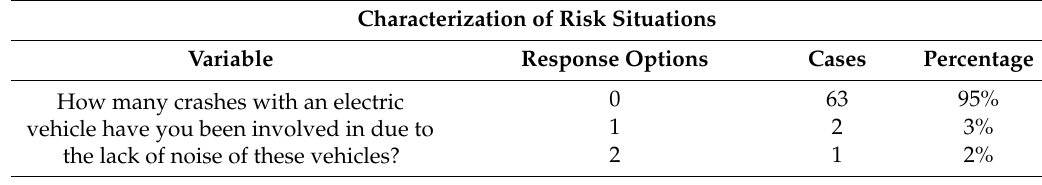
Table 2. Identification and characterization of risk situations by workers (n =